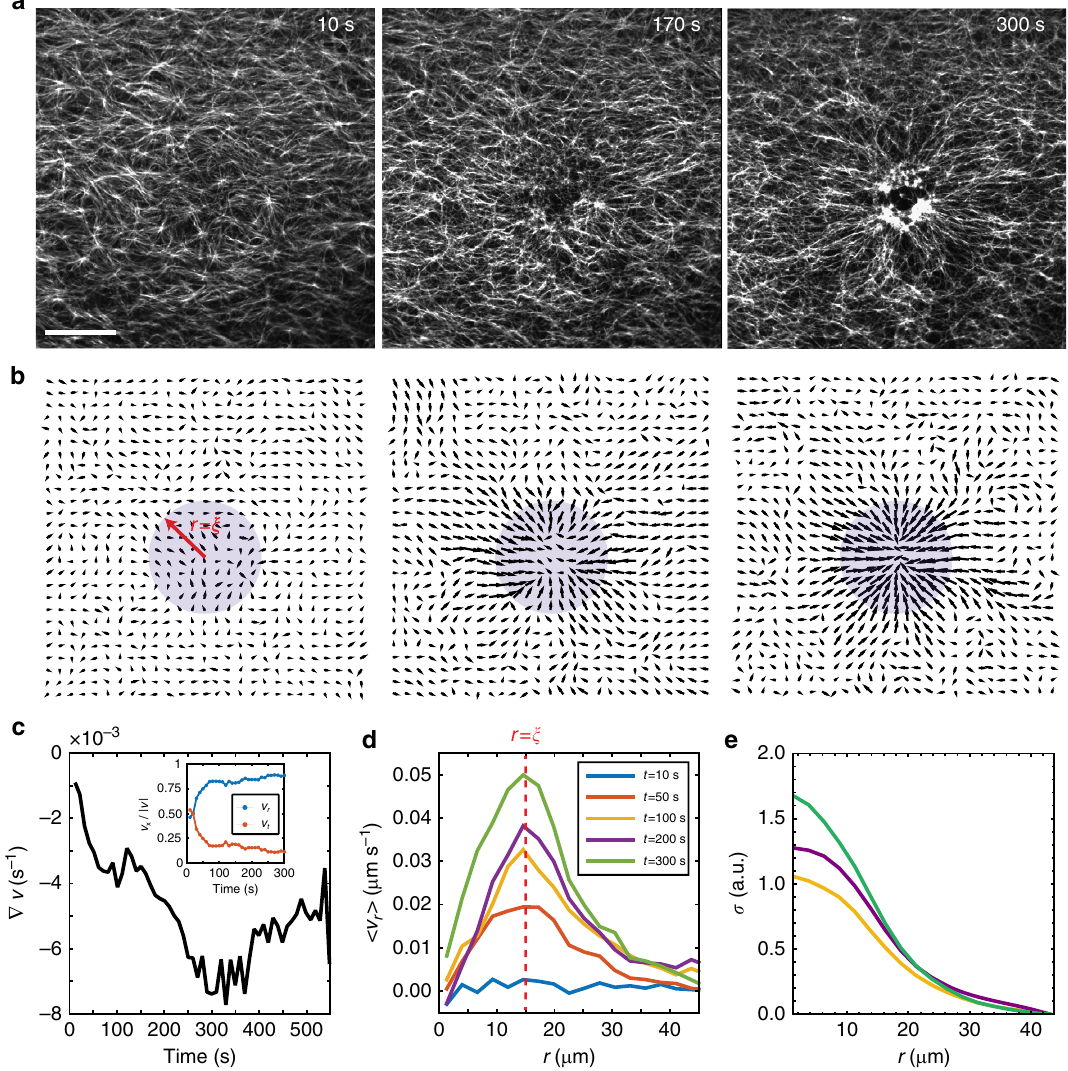
Figure 2 | Uniform contractility yields elevated boundary flows and accumulation of active stresses. ( a ) Images of F-actin network 10, 170 and 300s after the initial inactivation of blebbistatin. Scale bar, 20 m m. ( b ) Particle image velocimetry (PIV) of F-actin velocity field corresponding to images in a taken over 10s intervals. The myosin activation area (purple) is a circular region, defined by a radius r ¼ x , subject to 405nm illumination. Vector magnitudes are normalized across all time points. ( c ) Divergence of the F-actin velocity field (d t ¼ 10 s) averaged over the activation area. ( c , inset) Radial velocity (blue, v r ) and tangential velocity (orange, v t ) averaged over the activation area. ( d ) Mean velocity as a function of distance from the centre of the activation region, with positive values reflecting inward motion. ( e ) Predicted distribution of radial stress during contraction without assuming any materials properties of actomyosin (Supplementary Methods). Line colours correspond to timescales as indicated in d